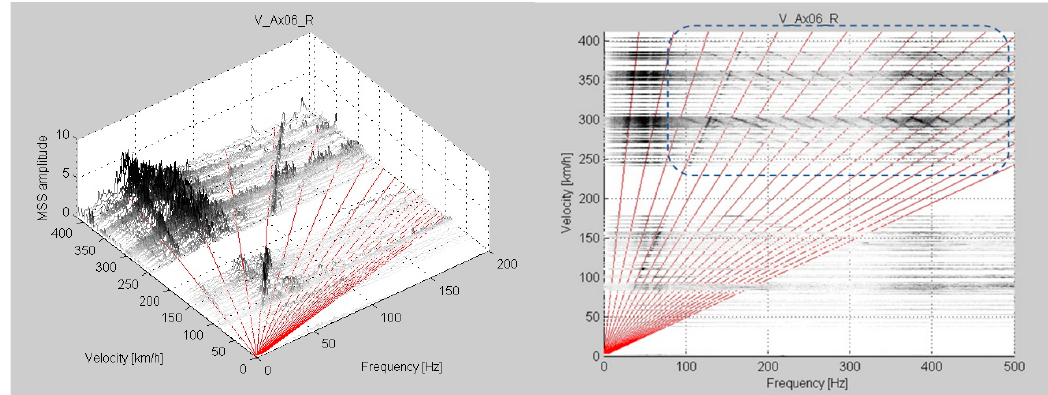
Electronics 2019 , 8 , x FOR PEER REVIEW